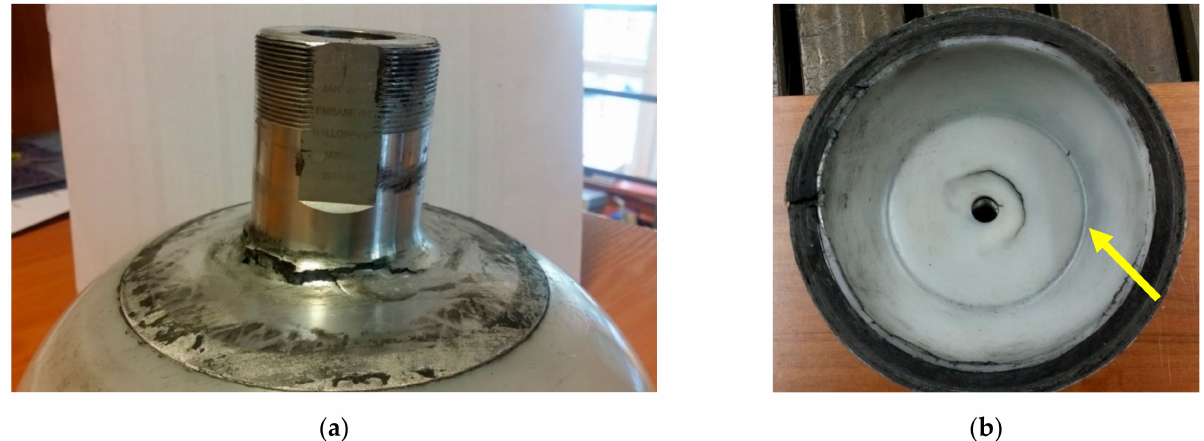
Figure 5. View of a damaged boss after fatigue testing. ( a ) Crack in the metallic boss and ( b ) crack in the inner side of the liner’s dome.